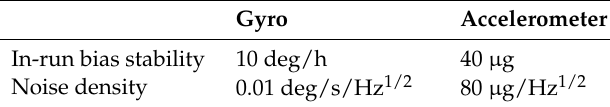
Table 1. IMU nominal specifications.